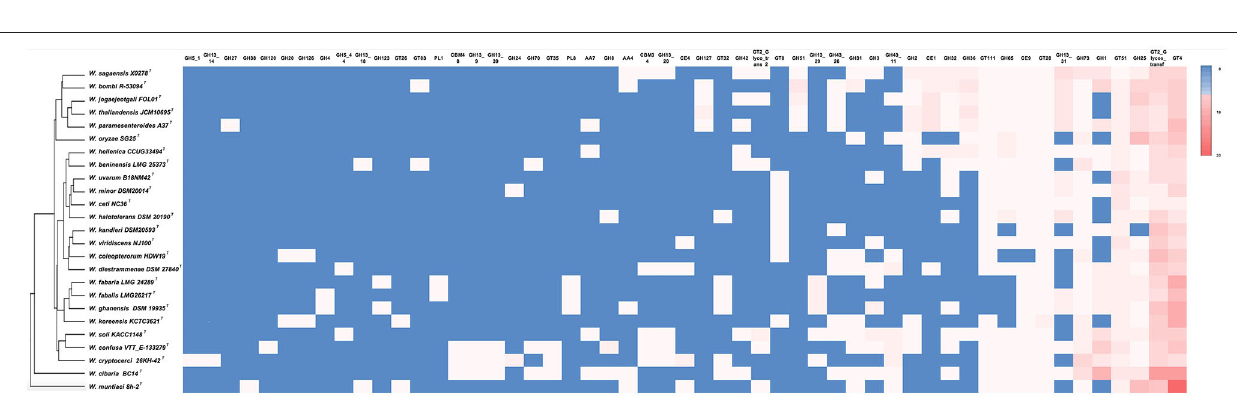
Furthermore, according to the comparative analysis